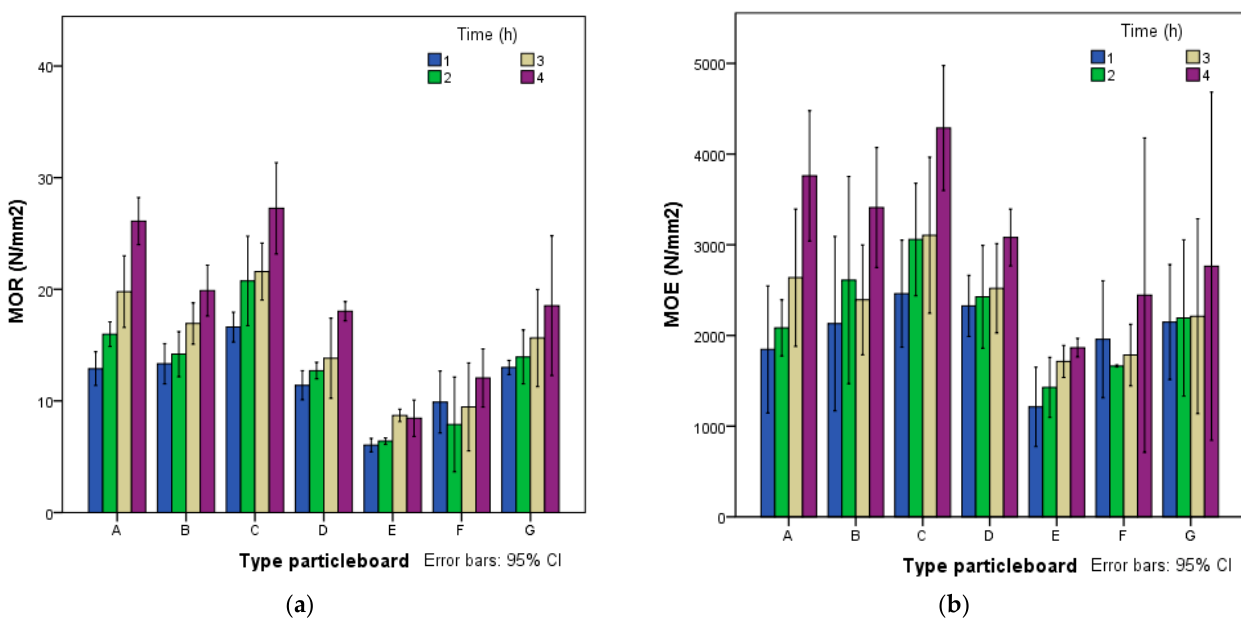
Figure 5. ( a ) Modulus of rupture (MOR) and ( b ) and modulus of elasticity (MOE). Type A and C boards, using starch and cement and a press time of 1 h, can be classified as P2. After being in the press for 4 h, these panels achieved the P7 requirements. The